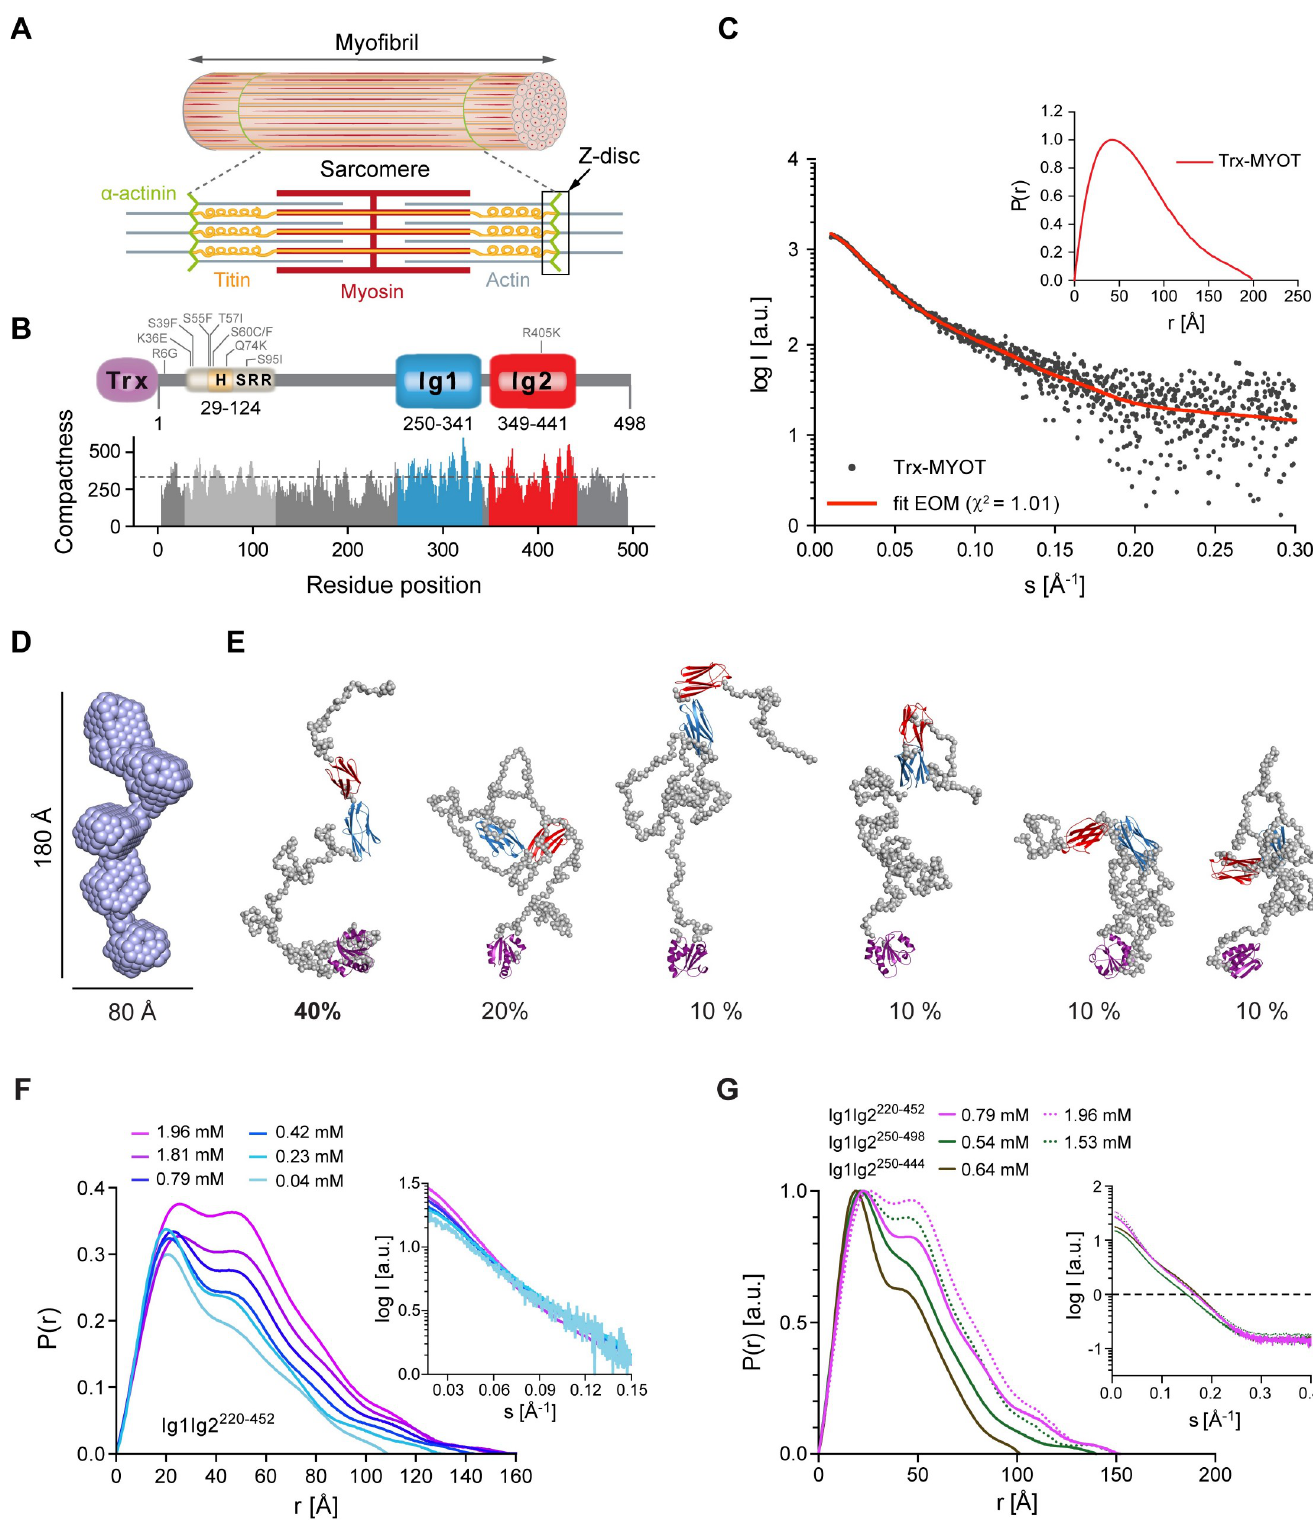
Fig 1. Myotilin displays conformational ensemble in solution. (A) Schematic representation of striated muscle sarcomere with its major thick (myosin based) and thin (actin based) filaments, titin, and the Z-disc anchoring cross-linker α -actinin. Extending from one Z-disc to the next, sarcomere represents the fundamental unit